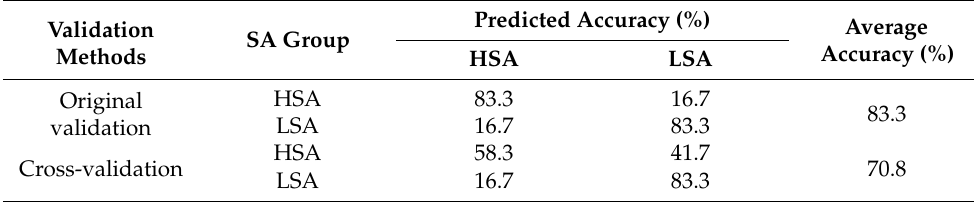
Table 5. Component matrix for SA-sensitive EEG